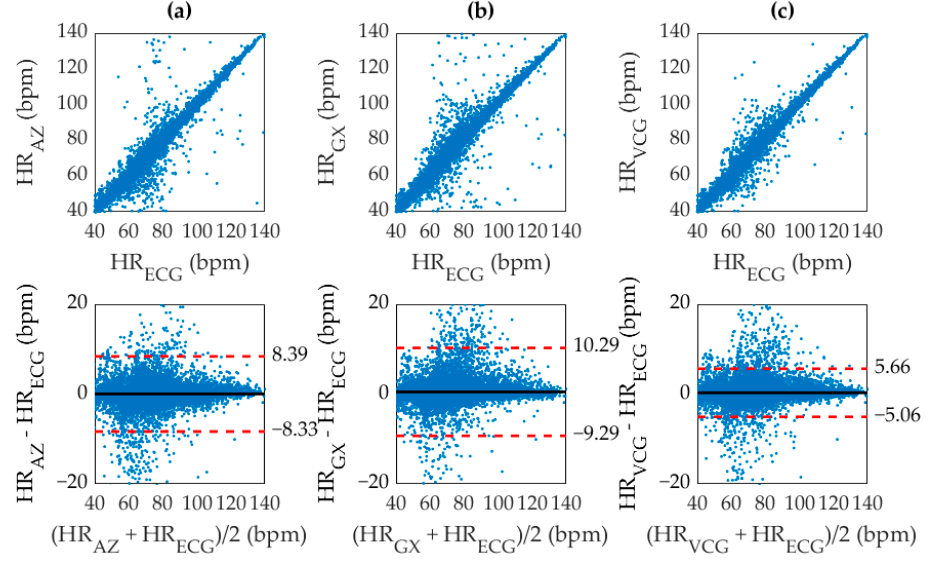
Figure 6. Correlation (top) and Bland Altman (bottom) plots for ( a ) SCG with r 2 of 0.9485, ( b ) GCG with r 2 of 0.9305, and ( c ) VCG with r 2 of 0.9783. The (black, solid) mean difference, and (red, dashed) 95% limits of agreement are shown overlaid.